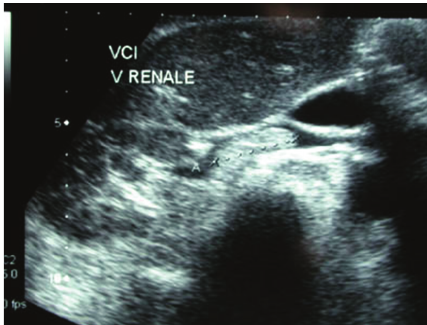
Figure1:SonographyoftheIVCthrombusoriginatedfromtheright renal vein.